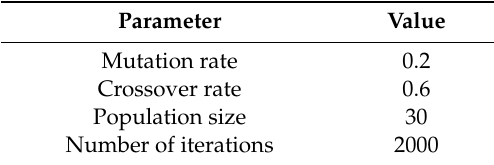
Table 2. The parameters used in the following simulations.